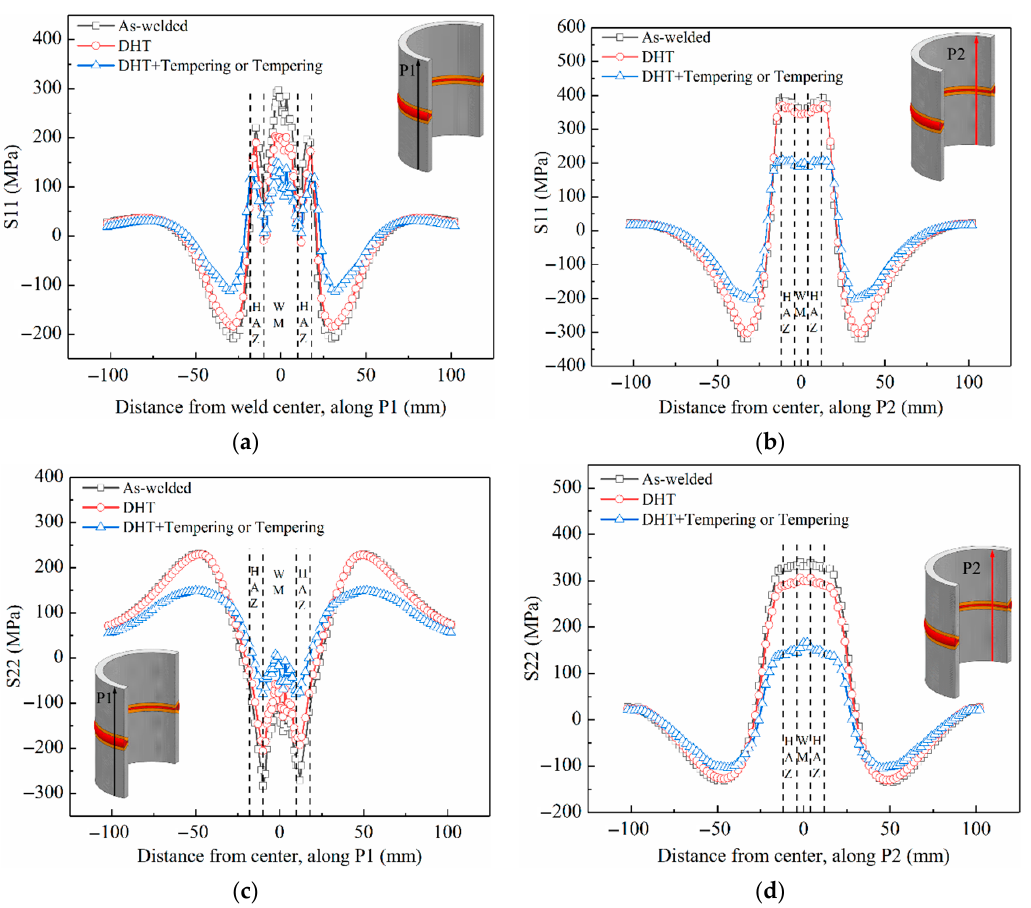
Figure 12. Residual stress distributions at different paths of the welded joint: S11 along P1 path ( a ) and P2 path ( b ); S22 along P1 path ( c ) and P2 path ( d ).